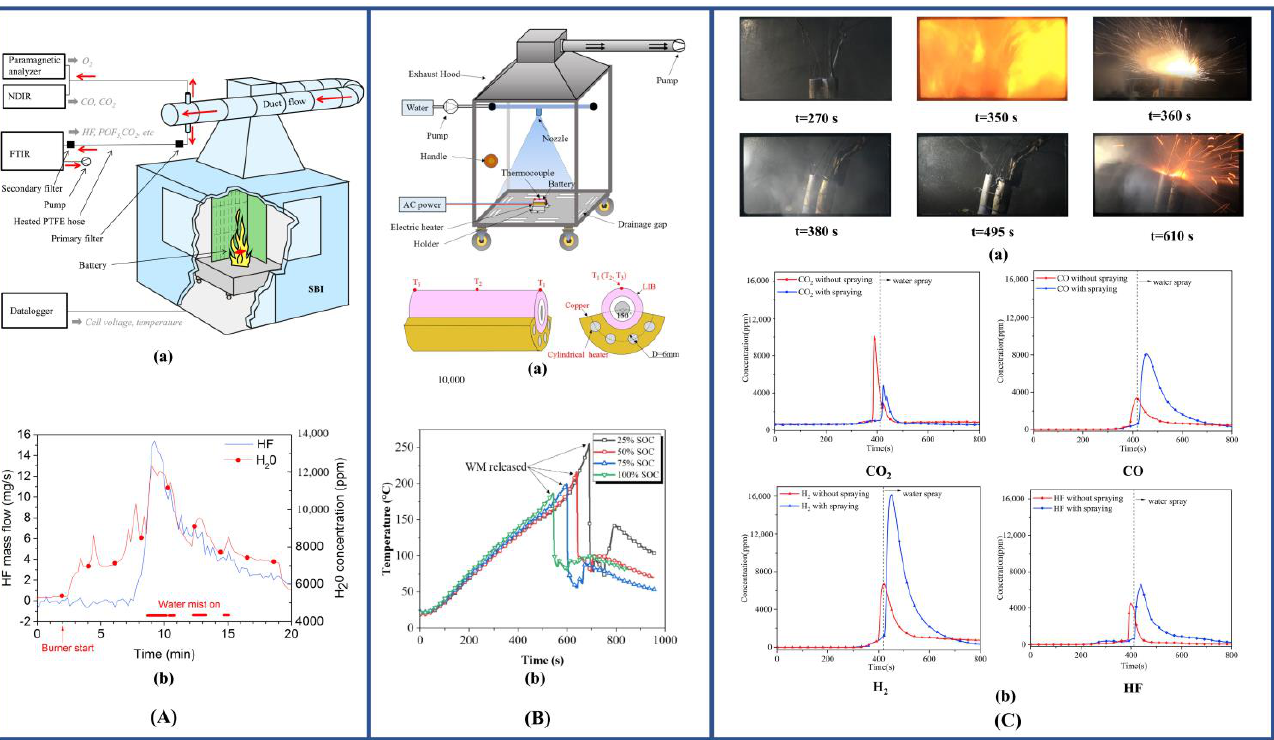
Figure 13. Study and analysis on thermal runaway suppression effect of jet cooling in overheated power battery. ( A ): Schematic illustration over experimental setup ( a ); HF mass flow and water concentration ( b ) [176]. ( B ): Schematic diagram of the experimental unit, heating element and LIB setup details ( a ); temperature curves of different charge states under WM inhibition thermal runaway ( b ) [175]. ( C ): Suppression of runaway thermal propagation by spray cooling ( a ); the concentration responses of four gases with and without water spray ( b ) [178].